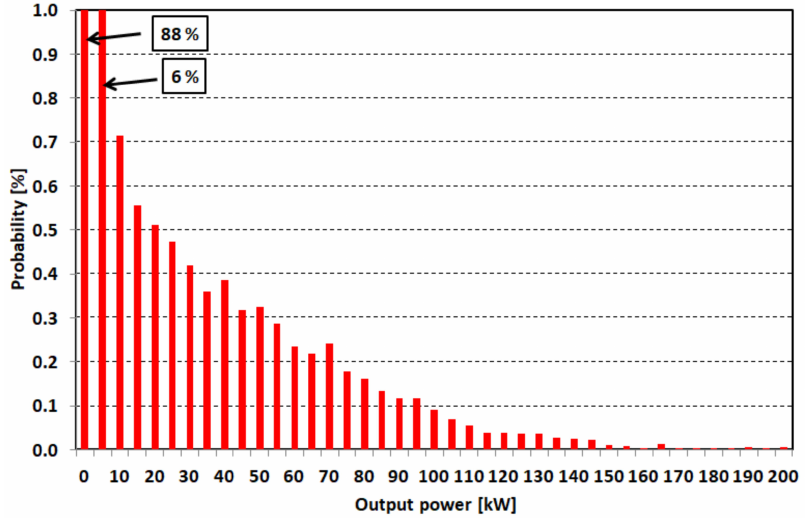
Figure 12. The histogram of output